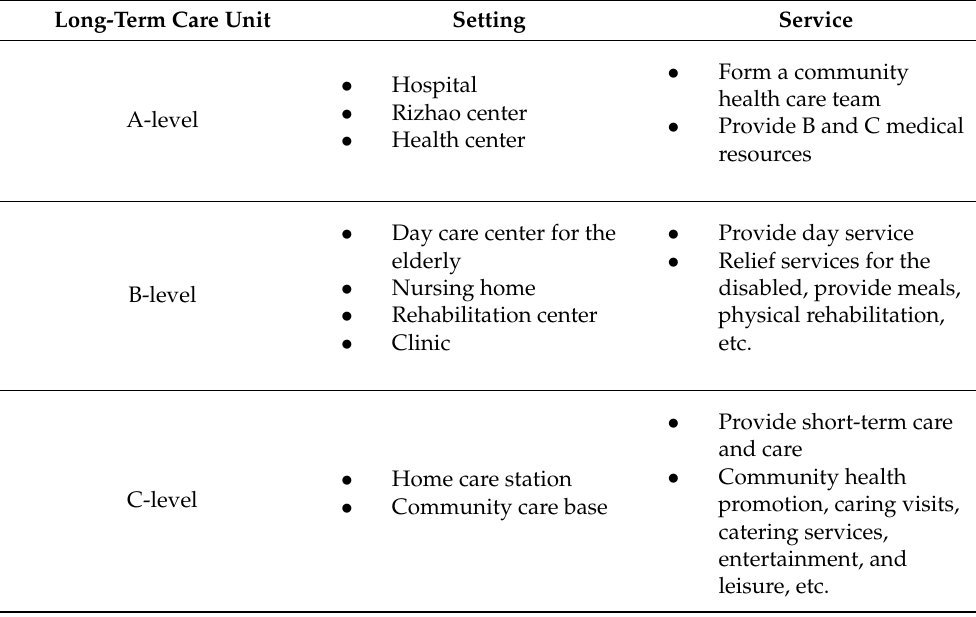
Table 1. Setting and service provided for each level of long-term care unit. Long-Term Care Unit Setting